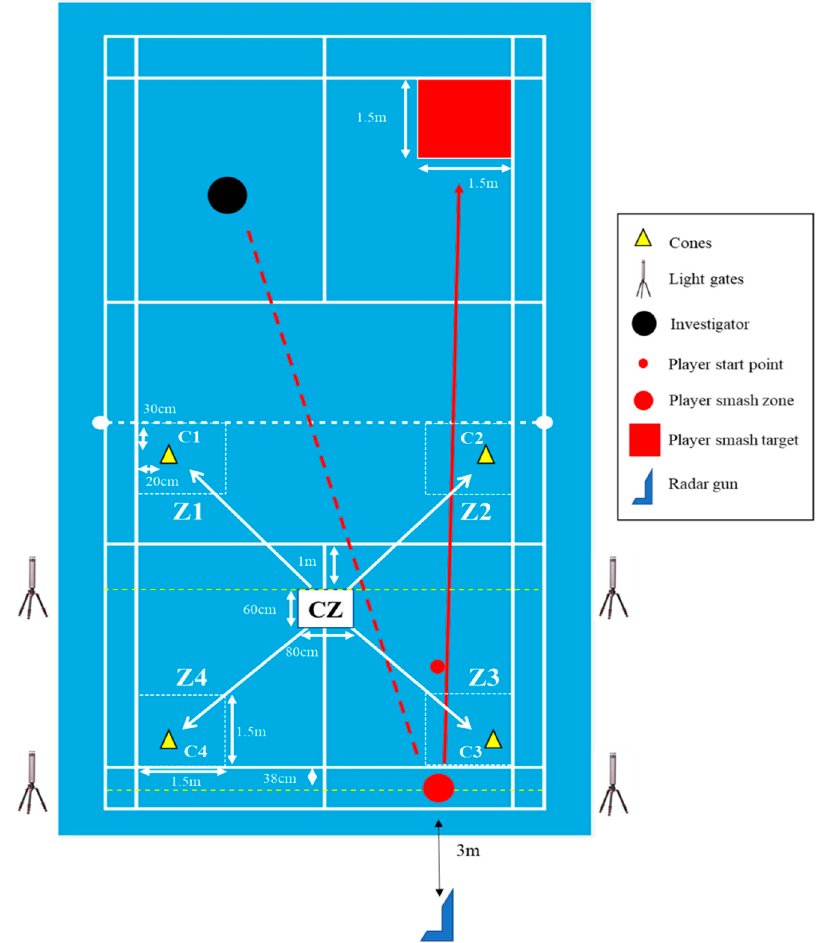
Figure 2. Layout of badminton court for simulated match rallies, change of direction speed (CODS), and smash velocity (SV) tests.